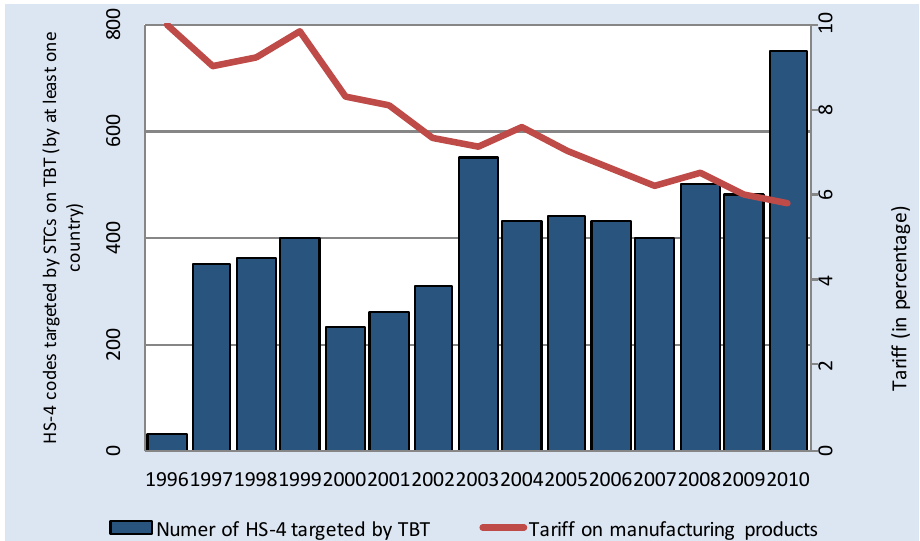
Figure 5. TBT trade concerns and applied tariff level